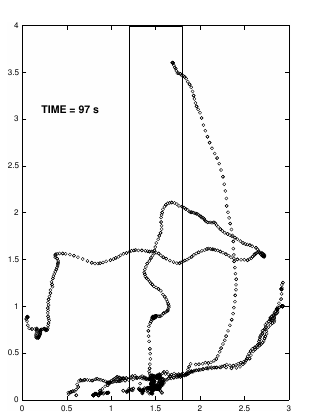
Figure 9. Example of child’s behavior during the test users are immersed in the active space and interact with it by moving their bodies, exactly as they do in common life. These human computer interaction elements may open the way to a new kind of assistive technology, which has the potentials of meeting blind children’s needs in a more natural and e ff ective